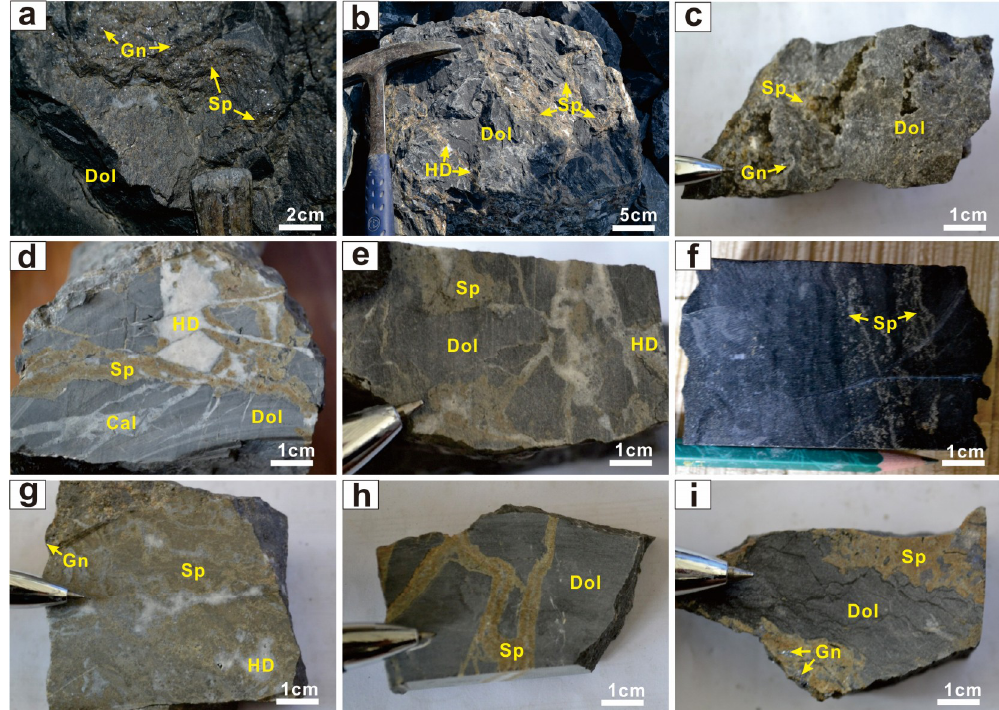
Figure 4. Mineral assemblages and textures of the samples from the Nayongzhi deposit. ( a ) Massive sphalerite and galena assemblage. ( b ) Vein-like Sphalerite and hydrothermal dolomite cemented the fragments of dolostone. ( c ) Fine-grain sphalerite and galena fill the vugs of dolostone. ( d ) Sphalerite and hydrothermal dolomite fill the fractures of the dolostone. ( e ) Stockwork of sphalerite distributed in the fragments of host rock. ( f ) Disseminated sphalerite hosted in the dolostone. ( g ) Massive sulfides including sphalerite and galena. ( h ) Vein sphalerite filling the dolostone. ( i ) Sphalerite-galena assemblage. Abbreviations: Sp Sphalerite; Gn galena; Dol dolostone; HD hydrothermal dolomite; Cal calcite.